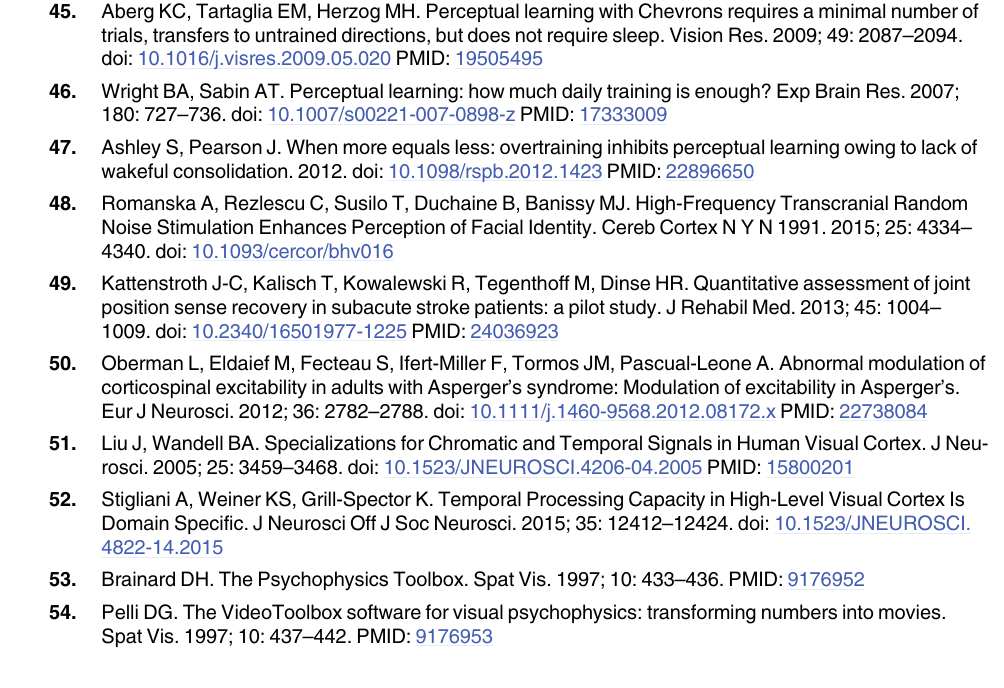
PLOS ONE | DOI:10.1371/journal.pone.0158312 June 24,